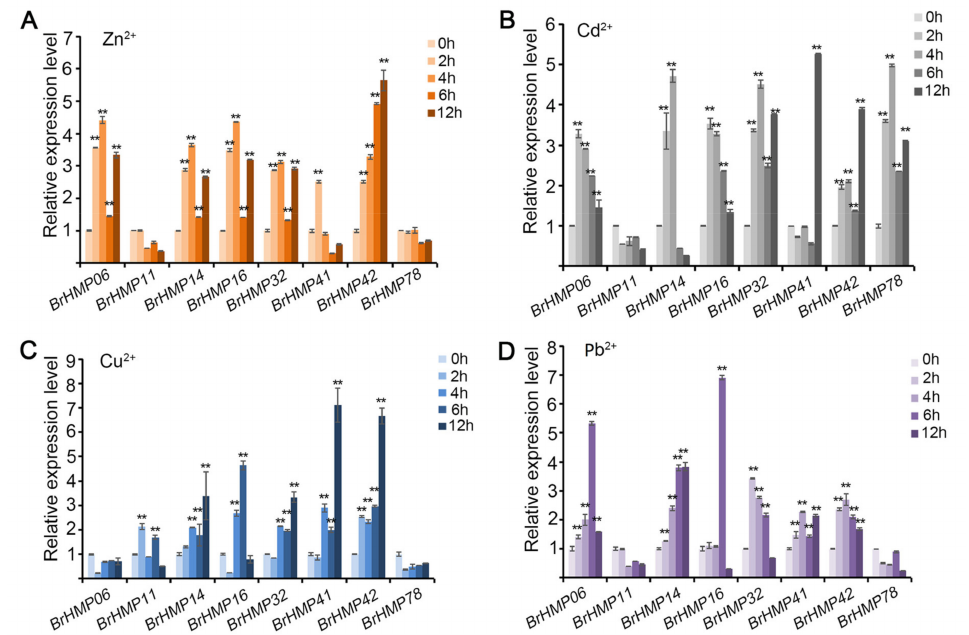
Figure 8. Expression profiles of BrHMPs in response to Zn 2+ ( A ), Cd 2+ ( B ), Cu 2+ ( C ), and Pb 2+ ( D ) stresses in B. rapa seedlings after treatment for 2 h, 4 h, 6 h, and 12 h, with 0 h as the control. Data are presented as means ( ± SD) of three biological replicates. ** p < 0.01, t